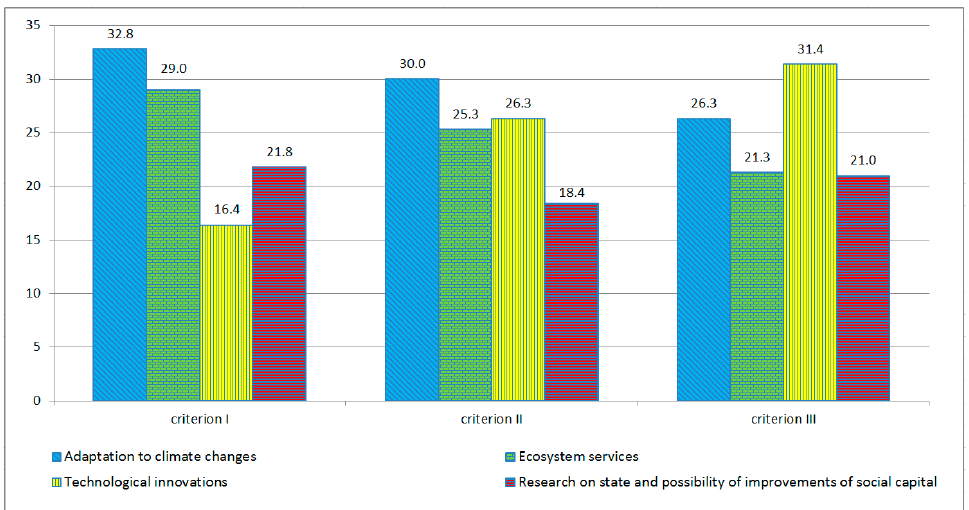
Figure 2. Expert CV prioritization on research areas depending on the criterion (% of total number of points). Source: Study results.